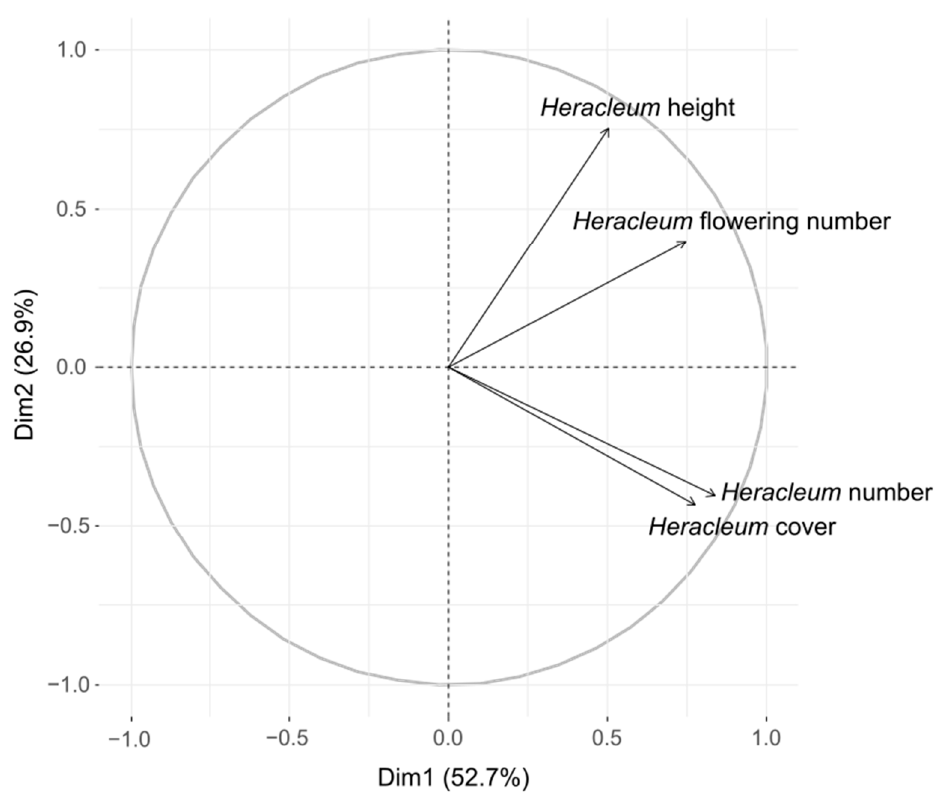
Figure 3. Principal component analysis PCA showing the relationships between invasiveness traits of Caucasian hogweeds in the 50 m radius study plots.